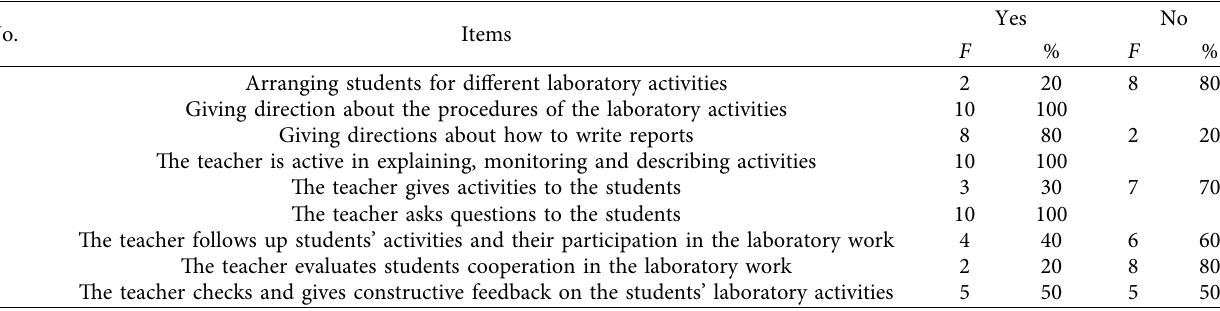
Table 6: Teachers’ activities.